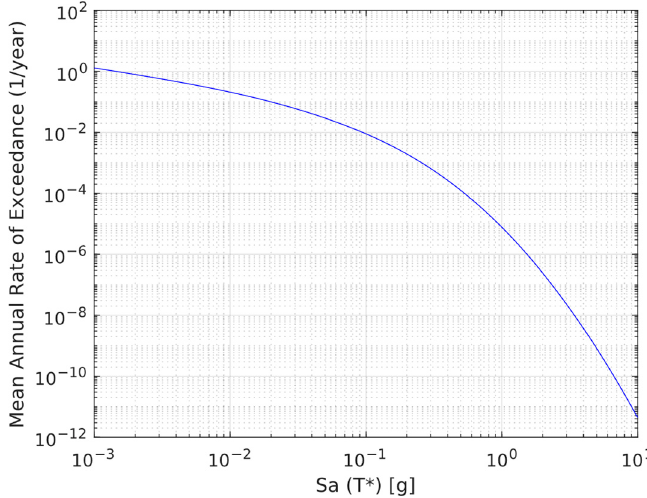
Figure 8. Seismic hazard curve for the studied buildings.